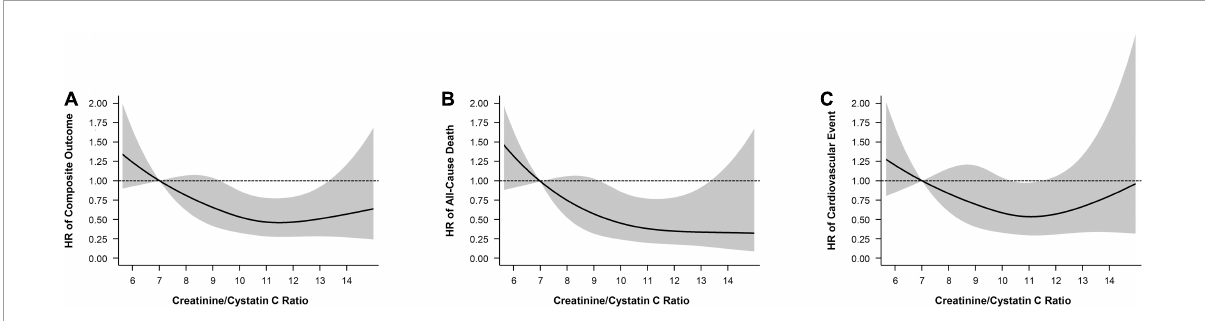
FIGURE2 Cubic spline model shows relationship of creatinine/cystatin C ratio with (A) composite outcomes, (B) all-cause death, and (C) cardiovascular events. Adjustments were made for model 2 variables (age, sex, eGFR, ACR, diabetes, cardiovascular disease, body mass index, smoking, albumin, C-reactive